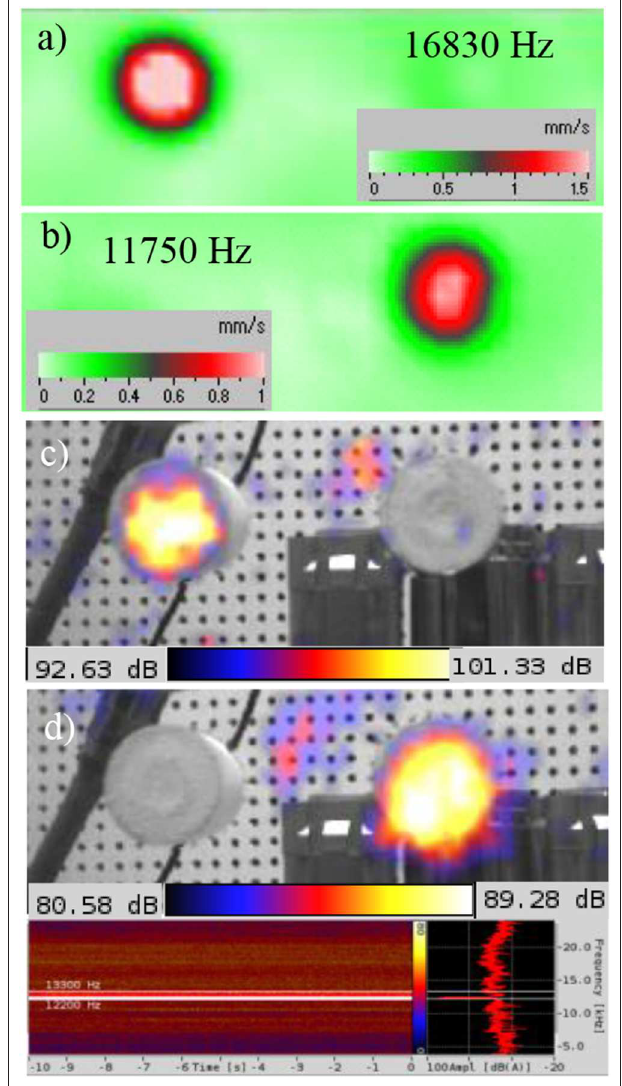
FIGURE 13 | Frequency-selective full-field RACE imaging (c,d) and laser vibrometry (a,b) for a pair of circular FBH of different LDR